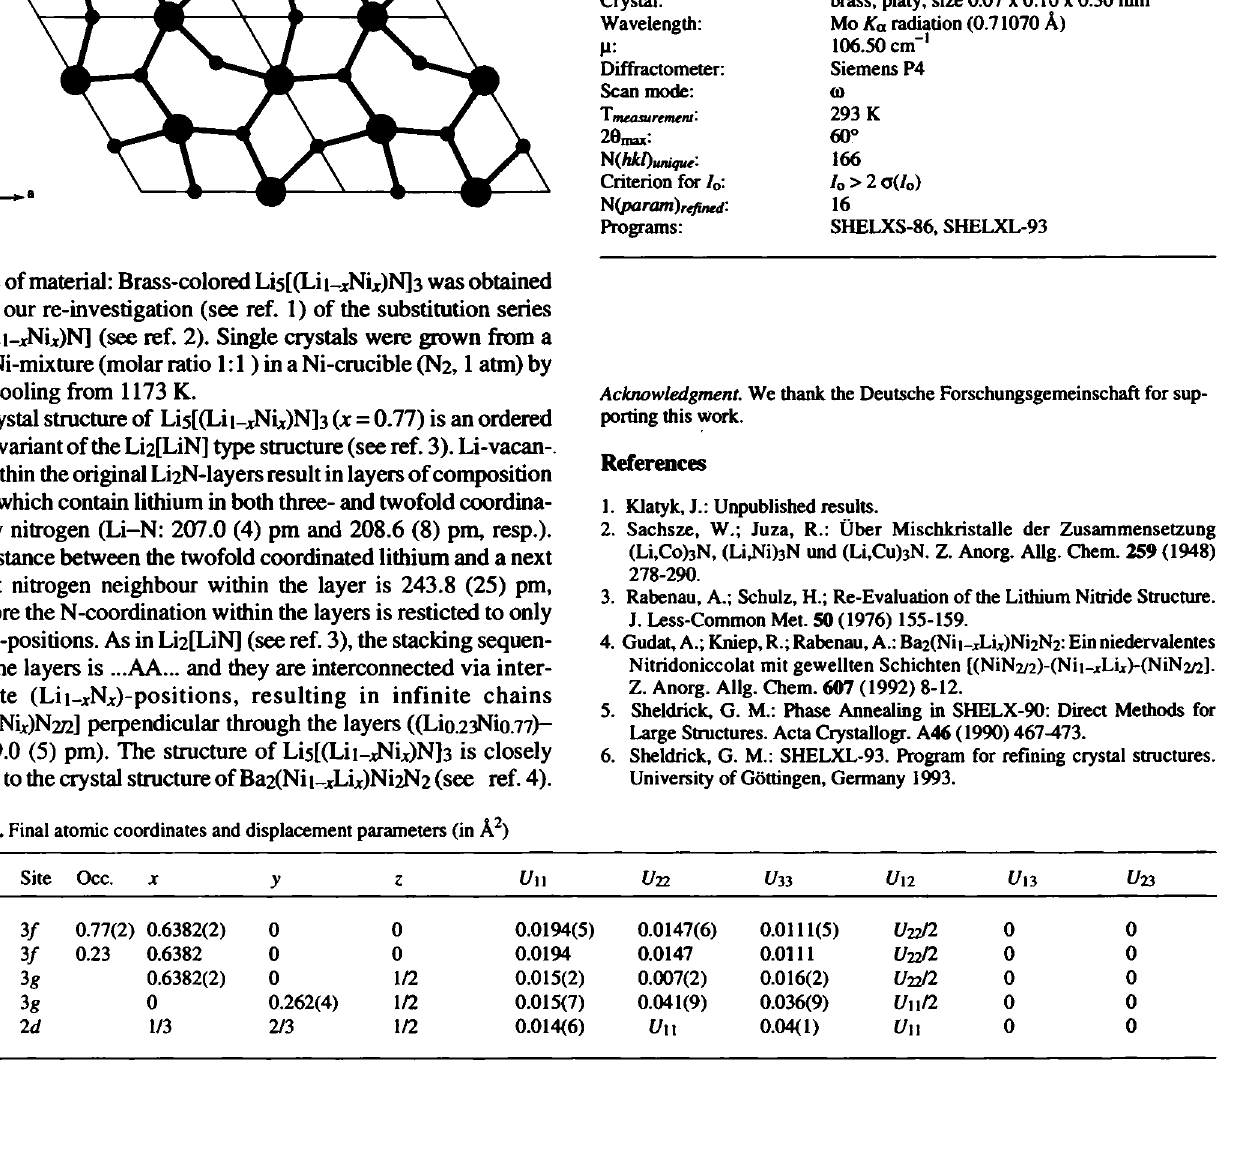
Table 1. Parameters used for the X-ray data